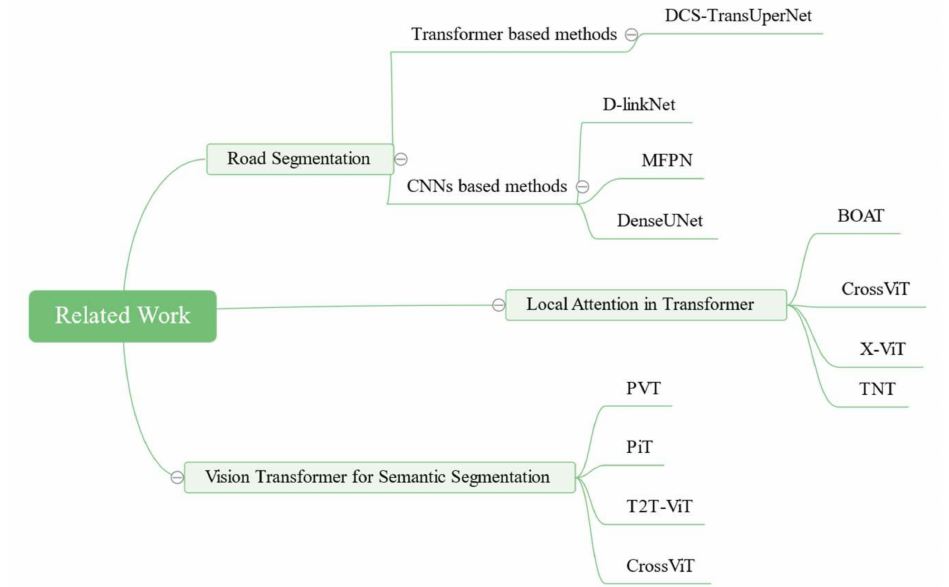
Figure 2. The overall context of related